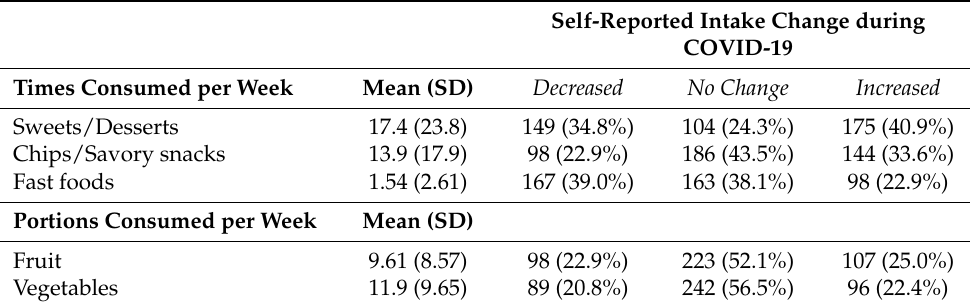
Table 3. Self-reported current food intake and change in food intake during COVID-19 ( n =